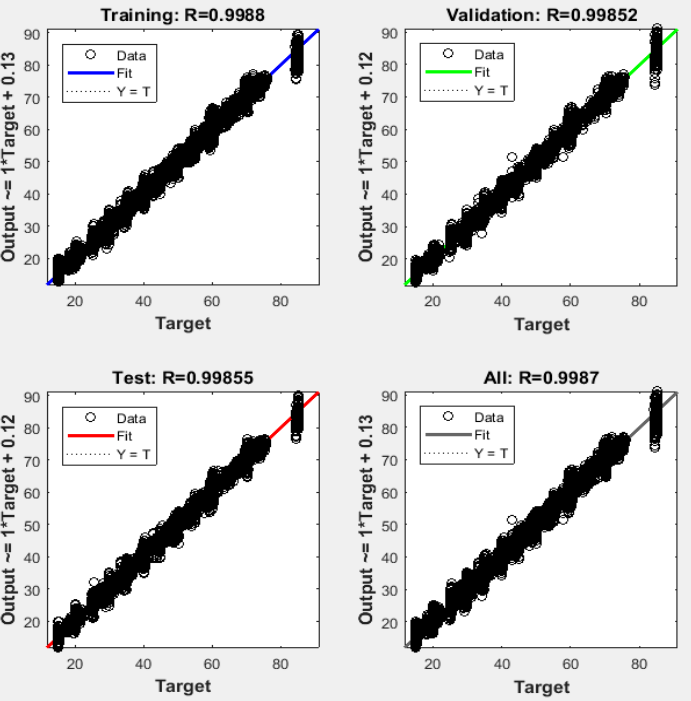
Figure 6. Regression plots of the training, testing, and validation data with the LM algorithm at 1000 neurons in the hidden layer.